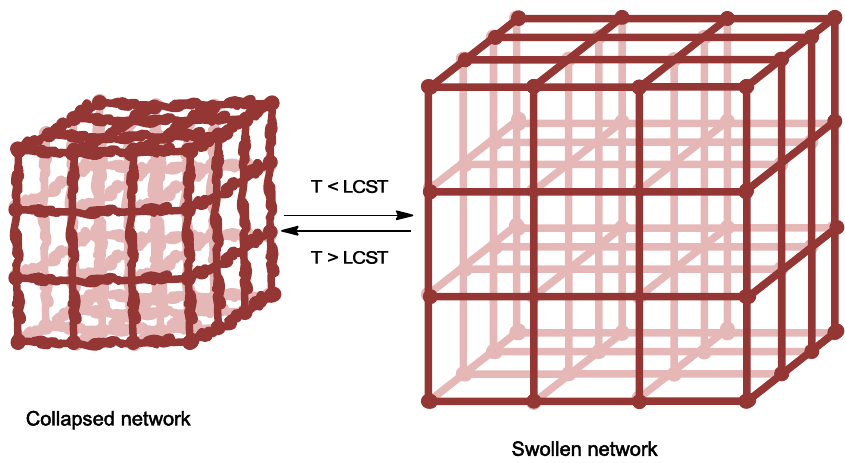
Figure 5. Effect of temperature on the swelling of covalently linked